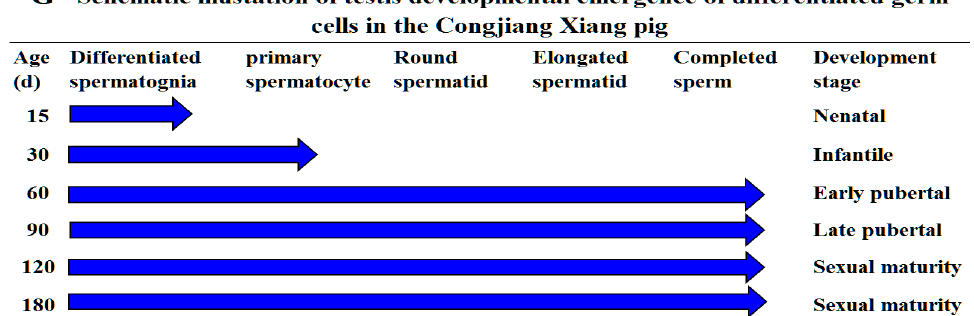
Figure 3. Histological observation of testes in Congjiang Xiang pig during development: ( A – F ) represent 15, 30, 60, 90, 120 and 180-day-old the Congjiang Xiang pig testes ( n = 3). ( G ) A schematic illustration of testis development emergence of differentiated germ cells in the Congjiang Xiang pig according to Yomogida K. (2009) [23]. Testes were removed and fixed in mDF 24 h, embedded in paraffin, sectioned (5 µ m) and stained with Hematoxylin and Eosin using standard procedures. Leydig cells (LC); Sertoli cells (SC); spermatogonia types A (SpA); spermatogonia types B (SpB); leptotene and zygotene spermatocytes (L/Z); preleptotene spermatocytes (PL); pachytene spermato- cytes (P); round spermatids (RS); elongating/elongated spermatids (ES). Scale bars (black line in the bottom-right of pictures): A–F = 100 µ m (200 ×